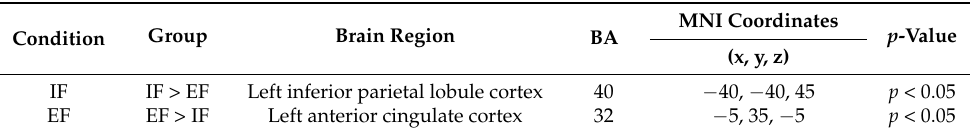
Figure 5. Comparison of theta activity of each group in IF and EF conditions. The red region represents the area where the theta activity was significantly higher in the IF-dominant group than the EF-dominant group. The blue region shows the area where the theta activity is significantly higher in the EF-dominant group than the IF-dominant group. The color bar represents the voxel log F-ratio values. ( a ) Comparison of the theta activity between the IF-dominant and EF-dominant groups in the IF condition. In the IF condition, the activity of the left parietal lobe (BA40) was significantly higher in the IF-dominant group than in the EF-dominant group ( p < 0.05). ( b ) Comparison of the theta activity between the IF-dominant and EF-dominant groups in the EF condition. In the EF condition, the activity of the left frontal lobe (BA32) was significantly higher in the EF-dominant group than in the IF-dominant group ( p < 0.05). EF: external focus; IF: internal focus. Table 2. Brain regions with significantly higher activity between the IF-dominant and EF-dominant groups.